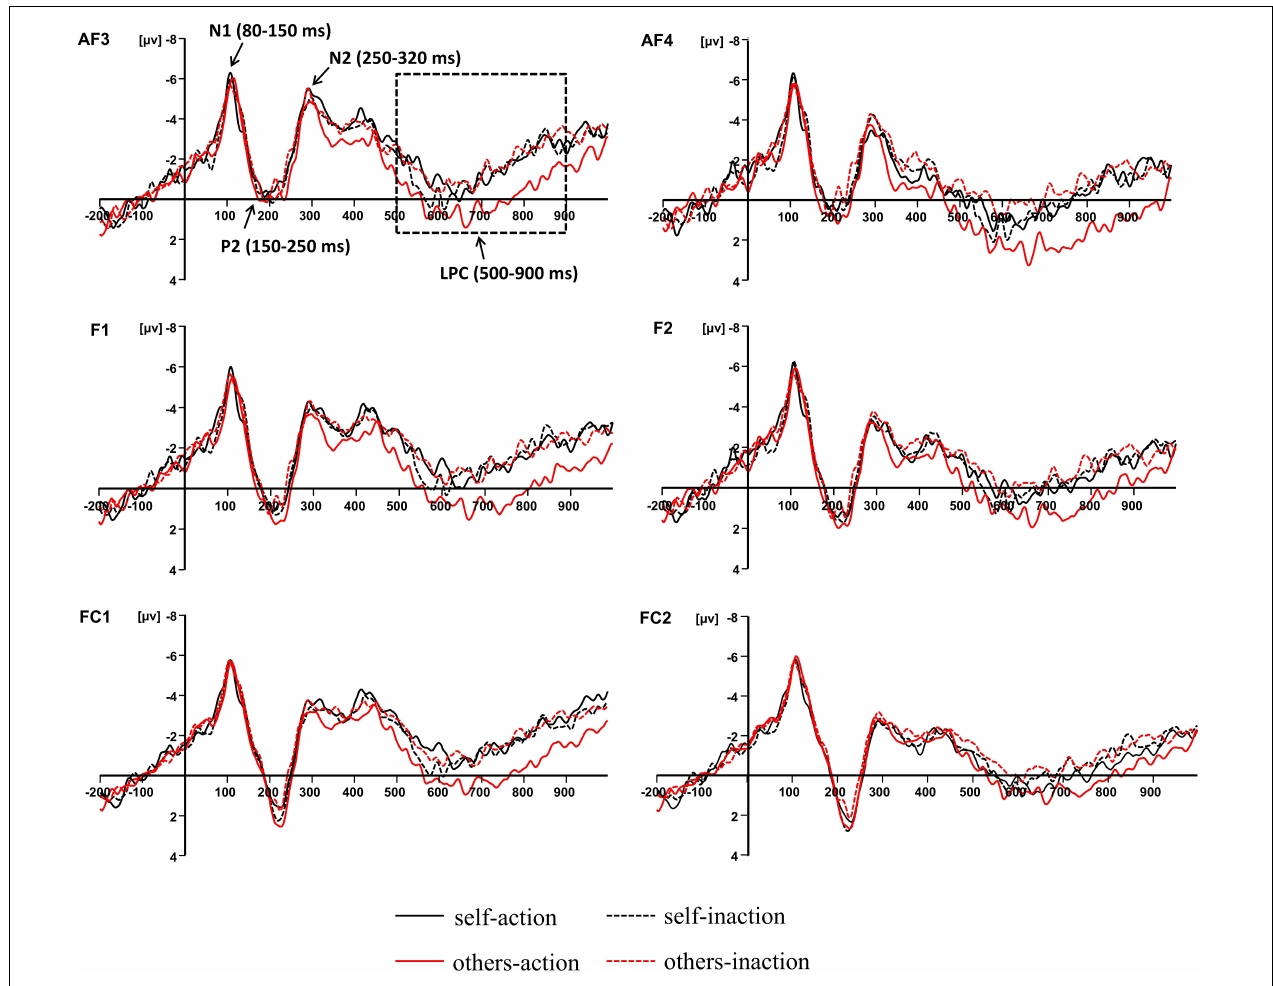
FIGURE 2 | Grand-averaged event-related potential waveforms elicited by four experimental conditions at frontal electrode sites.